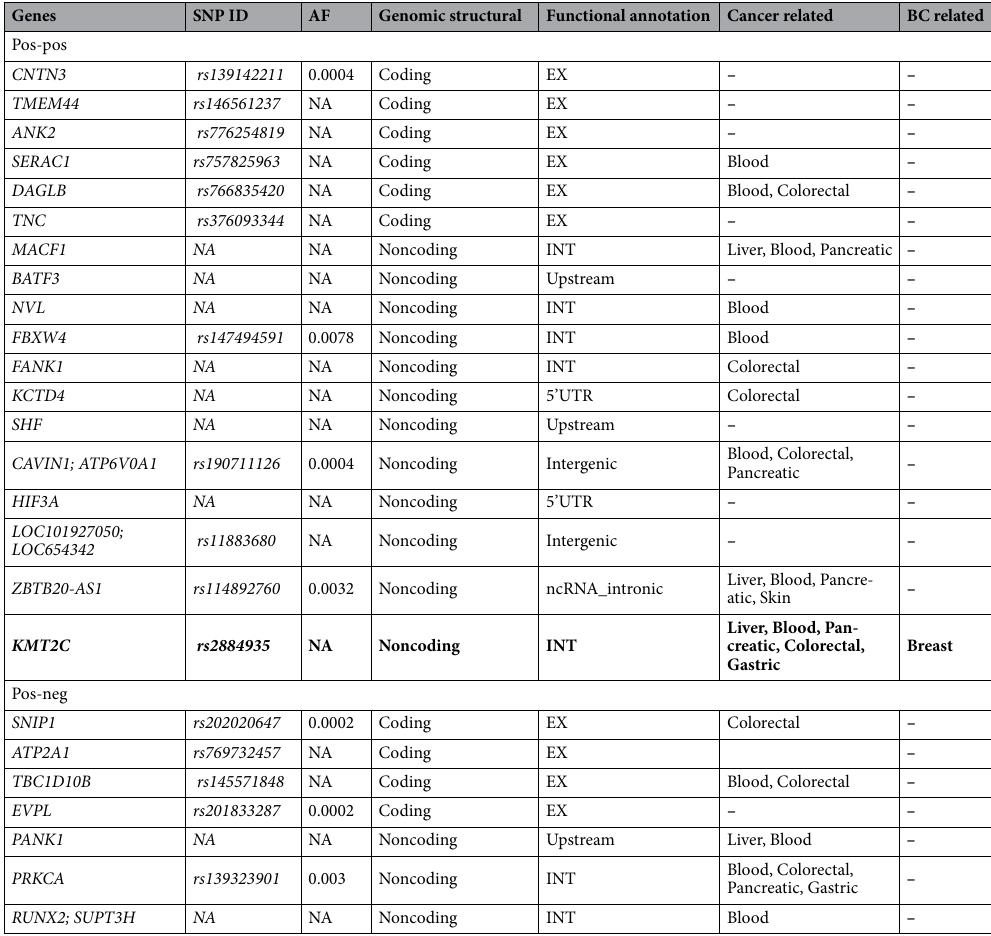
Table 5. Classification of detected variants by gene and cancer impact. Bold indicates genes associated with BC. AF 1000G Phase 3 all population Allele Frequency, Column in bold variant previously described as associated with cancer, BC Breast Cancer, SNP Single Nucleotide Polymorphism , Pos-neg positive–negative subjects, ID Identification, Pos-pos positive-positive subjects, rs reference SNP, INT intronic, EX EXonic, NA Not Applicable, G Group, Cancer related according to Candidate Cancer Gene Database. Significant values are in